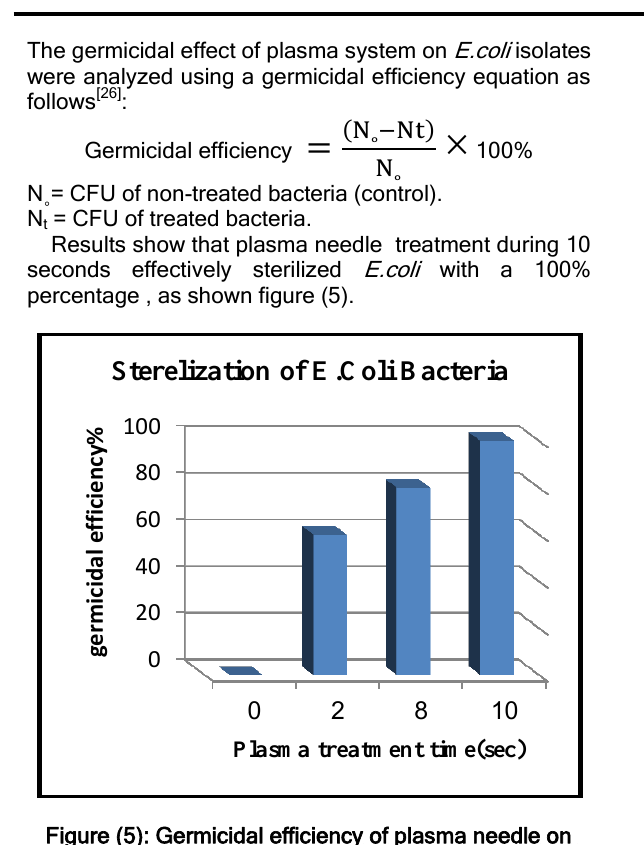
Figure (5): Germicidal efficiency of plasma needle on E.coli at different plasma treatment time.